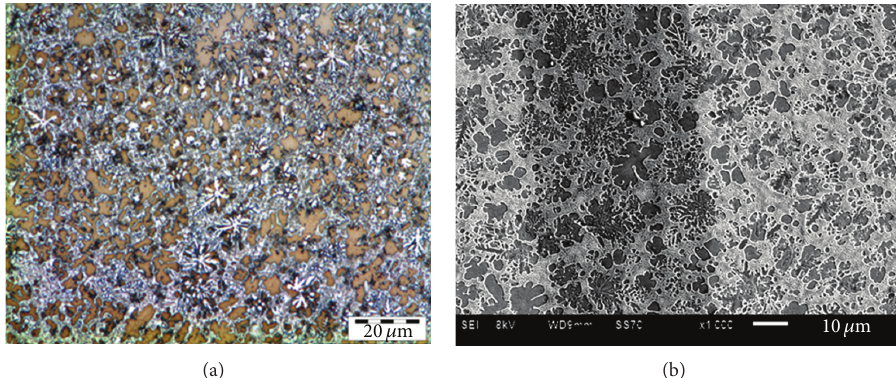
Figure 6: Micrographs of the laser deposited Ti45Ni55 coating; (a) optical image showing distribution of the phase in the coating; (b) SEM image showing a high magnification of the coating.